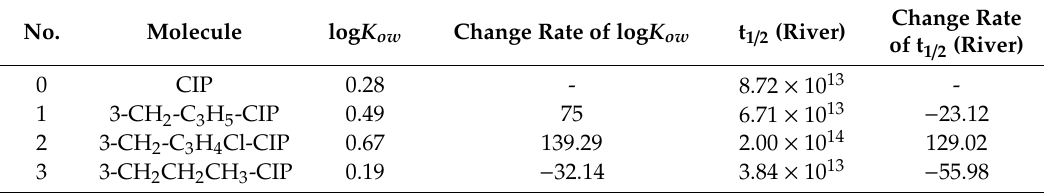
Table 6. Bioaccumulation and environmental persistence of the CIP